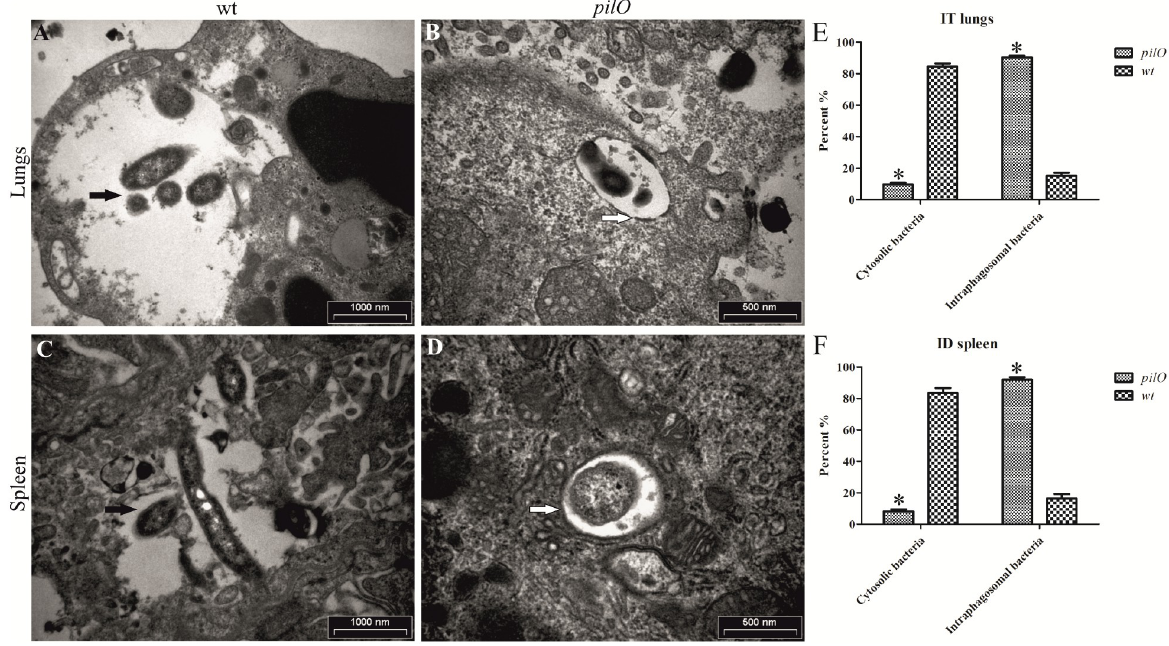
Fig 10. Ultrastructure of lungs and spleen tissue of infected BALB/c mice. Ultrastructure of organs was analysed by transmission electron microscopy (TEM) at 72 h post infection, to estimate the integrity of phagosomal membranes and the intracellular localization of bacteria. Shown are micrographs of the lung tissue of animals infected intratracheally (i.t.) with wt F . novicida (A) or the pilO mutant strain (B) , as well as the ultrastructure of spleen tissue of BALB/c mice after intradermal (i.d.) infection with wt F . novicida (C) and the pilO mutant strain (D) . Black arrows show bacteria, while white arrows show intact phagosomal membranes. Quantitative analyses were performed to assess the degree of cytosolic or intraphagosomal bacteria within the lungs of i.t. infected mice (E) , or in the spleen of i.d. infected mice (F) . Results are obtained by counting at least 100 bacteria for each sample. Asterisks denote that the localization of the pilO mutant is statistically different from that of wt F . novicida , as determined by Student t- test ( � , p <